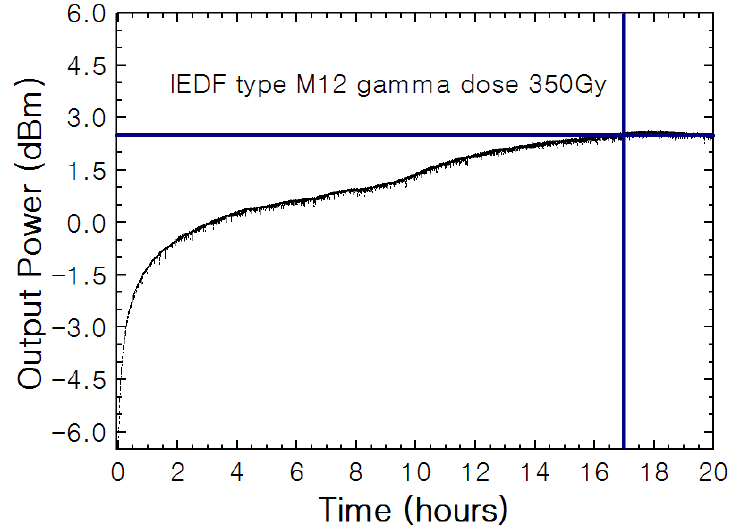
Figure 7. Fiber laser output power variation over 20 h when using 5 m of EDF M12 irradiated with 350 Gy when pumped by a 976 nm laser at 100 mW.